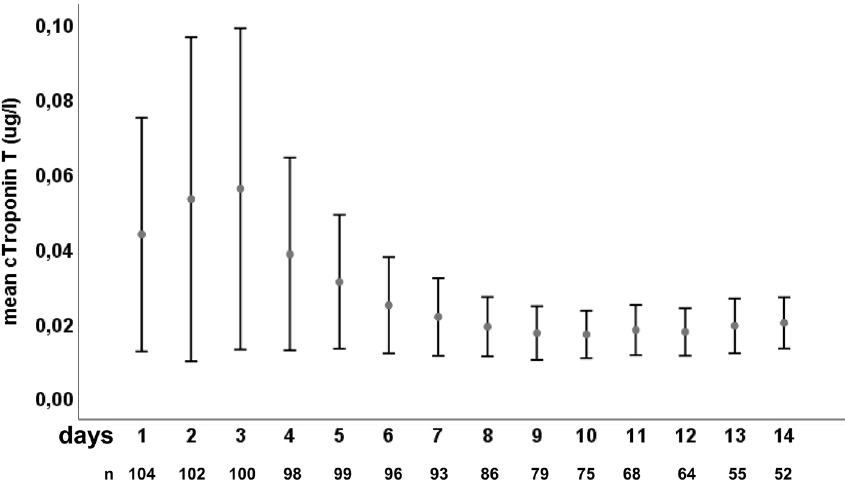
Figure 1. Troponin T levels over time. Mean high sensitive Troponin T levels on the first 14 days after subarachnoid hemorrhage (SAH). Bars represent 95% confidence interval (CI). Day 1 refers to admission.